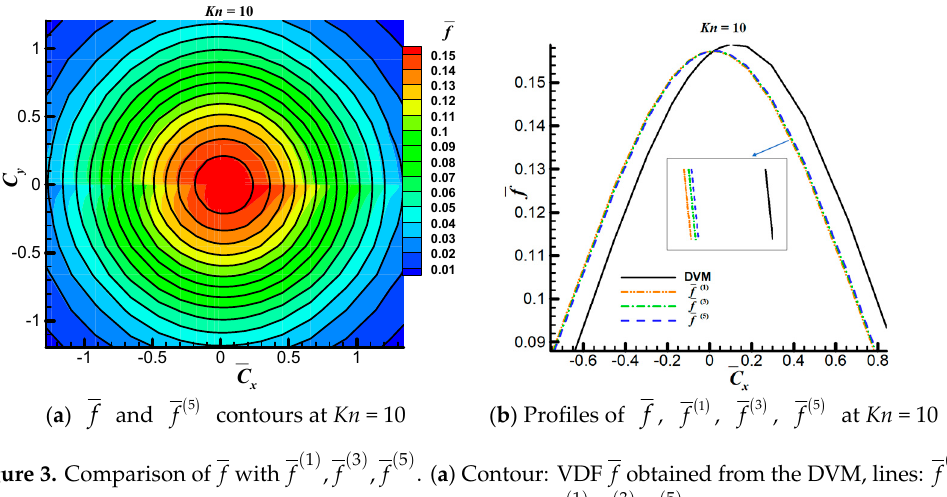
Figure 3. Comparison of f with f . ( a ) Contour: VDF f obtained from the DVM, ( ) 5 using the moments obtained from the DVM; ( b ) Profiles of f f using DVM lines: results. The corresponding errors of f numbers, i.e., Kn = 0.01, 0.1, 0.5, 1 are considered. The errors E channel are shown in Figure 4.